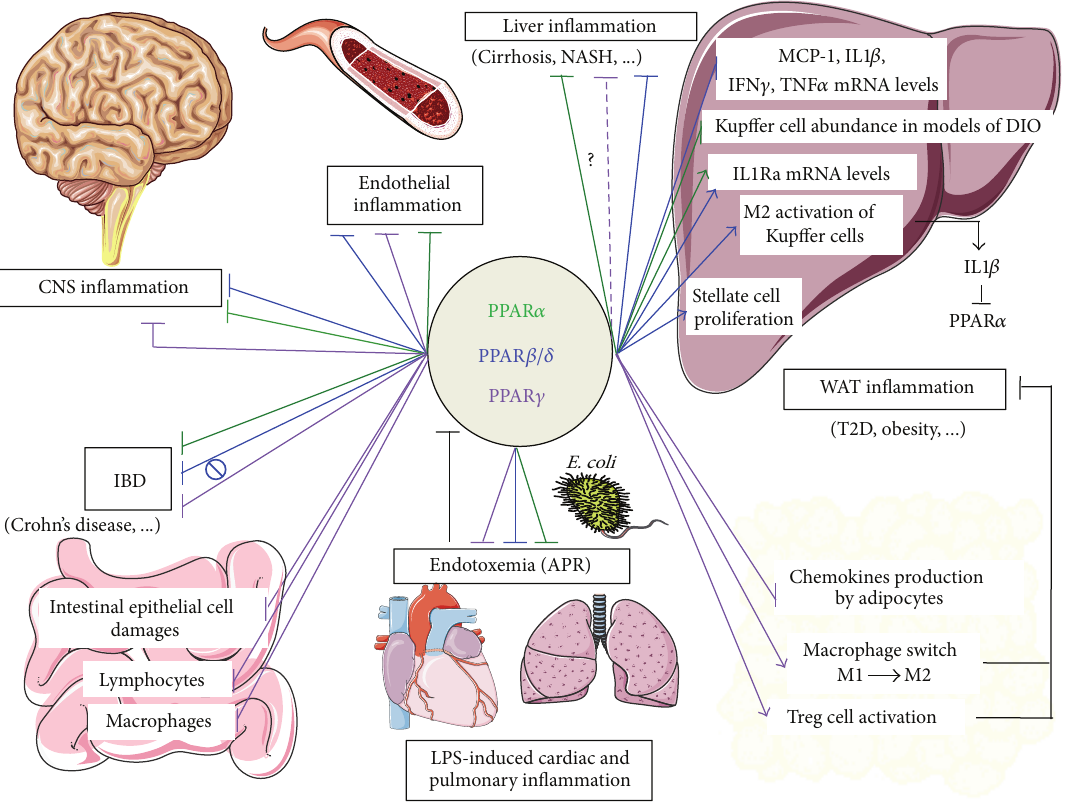
Figure 2: Representative illustration of PPAR main targets in inflammatory diseases. PPAR 𝛼 mostly displays anti-inflammatory properties in the context of liver inflammation. Its reported liver targets are hepatocytes and K¨uppfer cells [131]. IL-1 𝛽 produced by K¨uppfer cells potently suppresses Ppar 𝛼 expression and activity via NF- 𝜅 B–dependent inhibition of PPAR 𝛼 promoter activity [160]. Besides downregulating gene expression of proinflammatory mediators such as Mcp-1 , Tnf- 𝛼 , Ifn- 𝛾 , IL-1 𝛽 , and PPAR 𝛼 also directly controls expression of IL1-ra in liver [131, 163]. K¨uppfer cell activation is also dependent on PPAR 𝛽 / 𝛿 , which also targets stellate cells and therefore prevents liver fibrosis [75, 138]. In addition, PPAR 𝛽 / 𝛿 has well-established anti-inflammatory properties in diseases associated with CNS inflammation. In CNS, PPAR 𝛽 / 𝛿 has also proven anti-inflammatory properties in neurons, glial cells, and astrocytes [200–202]. PPAR 𝛾 anti-inflammatory properties are mainly illustrated in T2D and IBD. PPAR 𝛾 serves as the molecular target of the insulin-sensitizing TZD drugs and plays a key role in T2D, adipogenesis and obesity. In WAT, mature adipocytes, Treg cells and macrophages have been identified as key cellular targets for PPAR